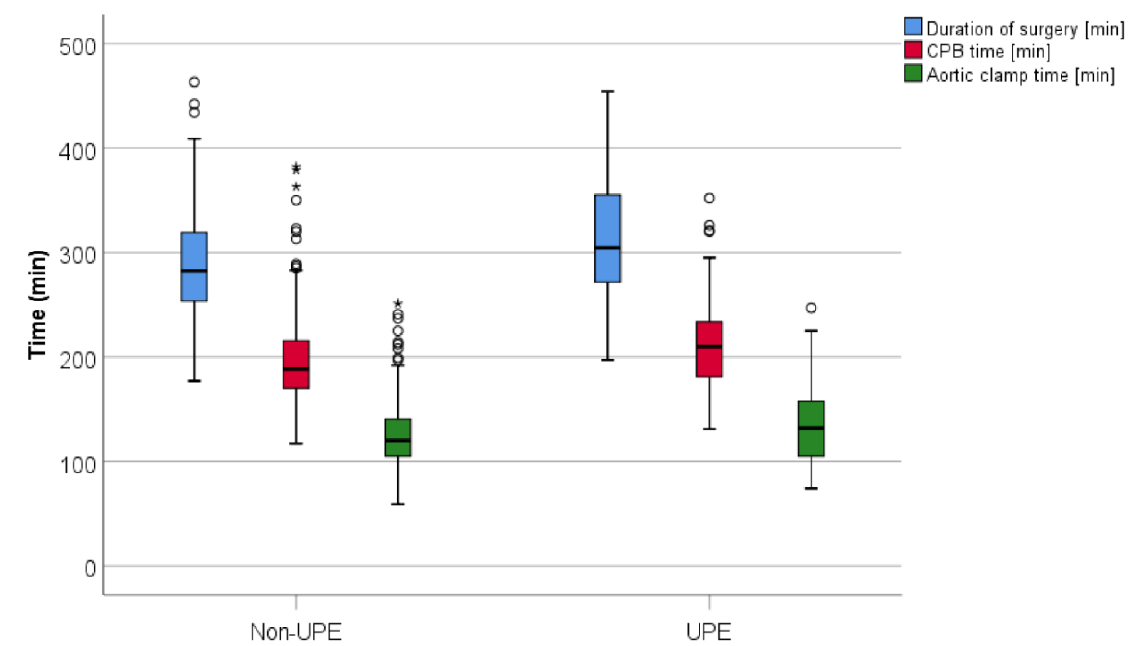
Figure 4. Duration of surgery, cardiopulmonary bypass (CPB) time and aortic clamp time in the non-UPE and the UPE groups. UPE, unilateral pulmonary edema; three outliers (duration of surgery, non-UPE, 590–1139 min) were excluded for the graphical representation, ◦ outlier; * extreme outlier.